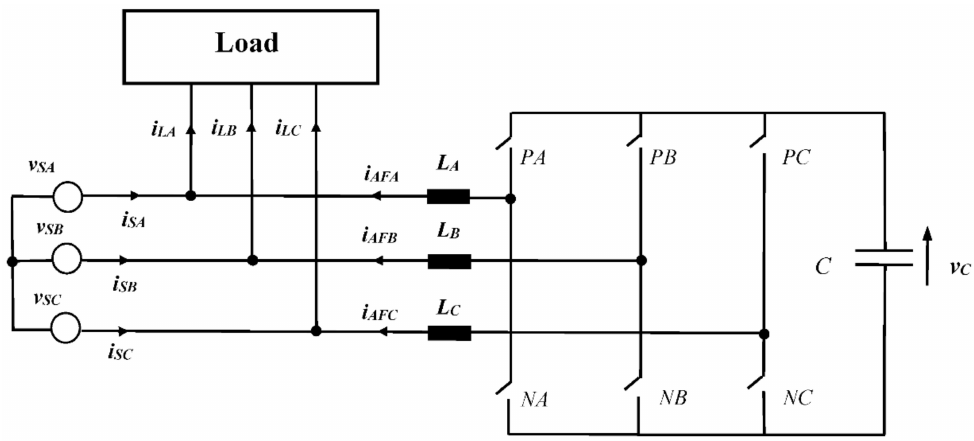
Figure 2. Basic scheme of three-phase three-wire circuit with active power filter. The numerator of the right-hand size fraction in (1) is related to the load instantaneous power and the denominator can be considered as the instantaneous norm of the source voltage. All phase voltages and currents have to be sensed to calculate the conductance signal